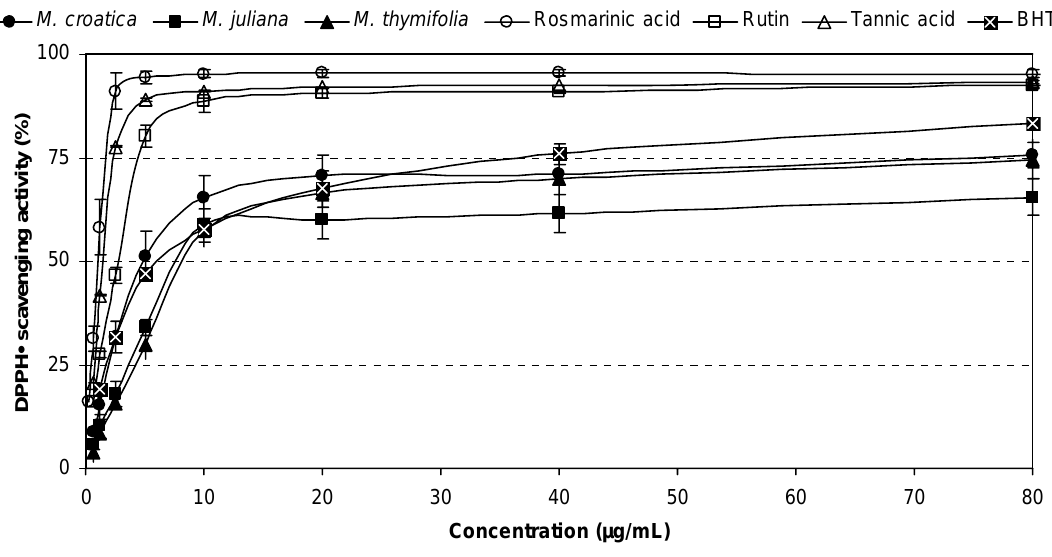
Figure 2. DPPH free radical scavenging effects of Micromeria ethanolic extracts in comparison with polyphenolic compounds and a reference